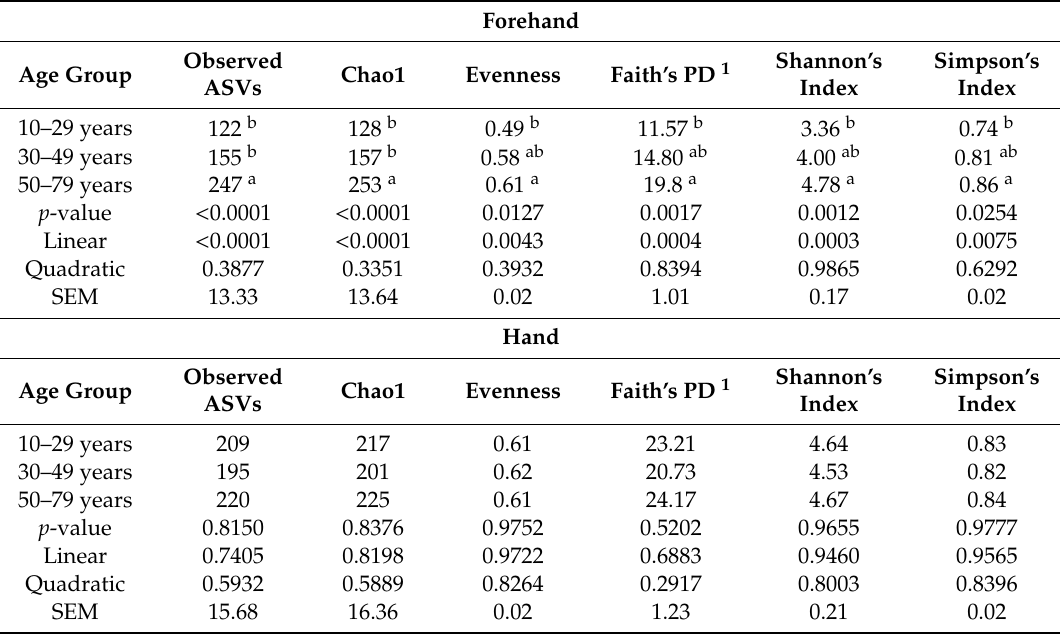
Table 4. Alpha-diversity measurements by age groups. Forehand